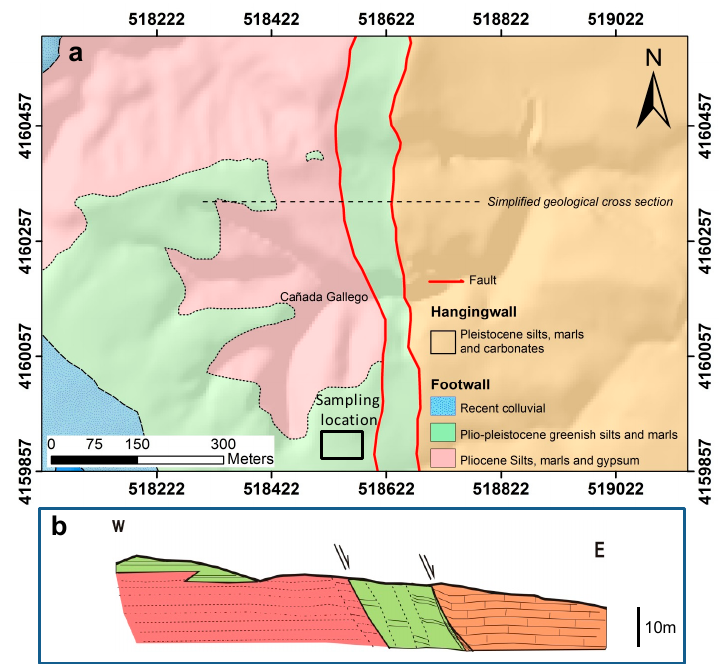
Figure 3. ( a ) Geological–geomorphological map of the northern sector. Location in Figure 1. ( b ) Geological cross section along the northern sector of the Baza Fault.